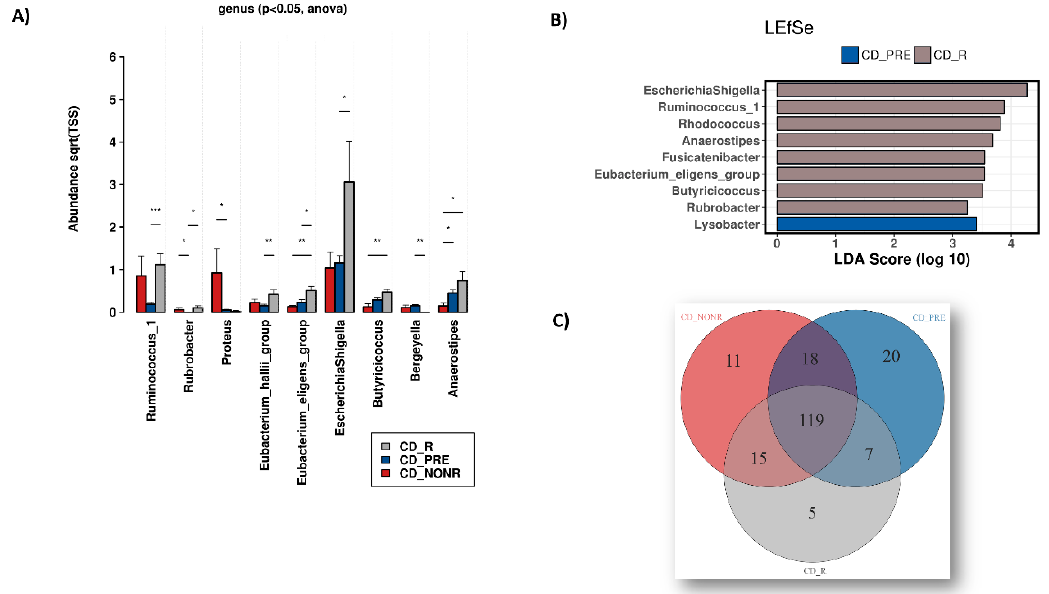
Figure 5. ( A ) Relative abundance of microbial genera among Crohn’s disease patients before treatment (CD_PRE) and after treatment in non ‐ responders (CD_NONR) and responders (CD_R). ( B ) LEfSe analysis showcasing microbial genera associated with the sample groups. ( C ) Venn Diagram depicting the microbial genera constantly present (core microbiome) in the samples of the 3 groups versus those found only in responders, non ‐ responders and at baseline (before initiation of treatment).